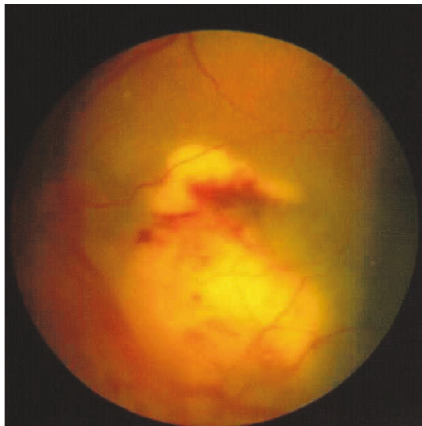
Figure 3: View through vitrectomy of the first